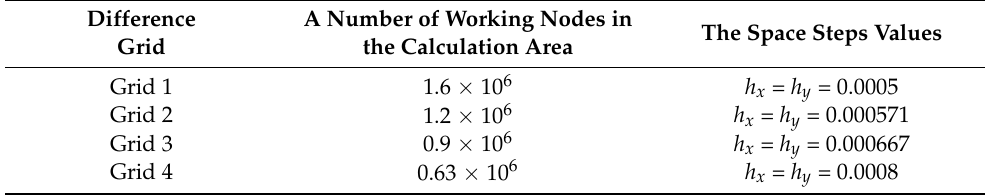
Table 1. Characteristics of the using difference grids.